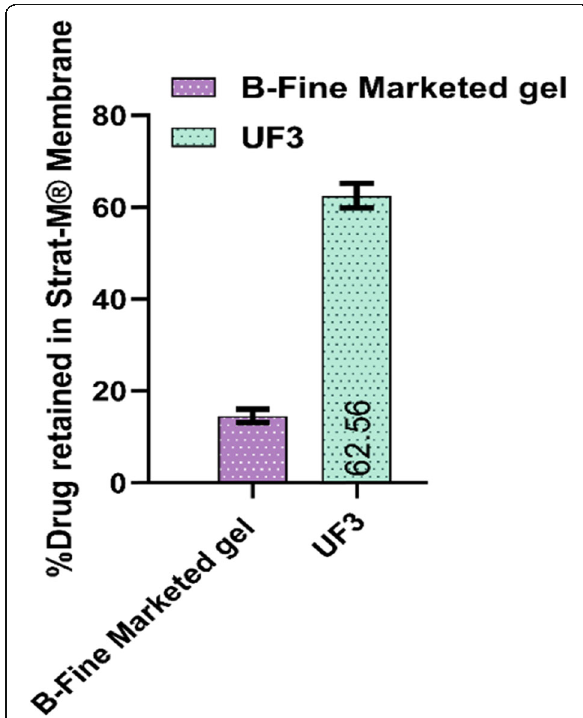
Fig. 7 Percentage drug retention of UF3 and B-Fine marketed formulation in Strat-M®